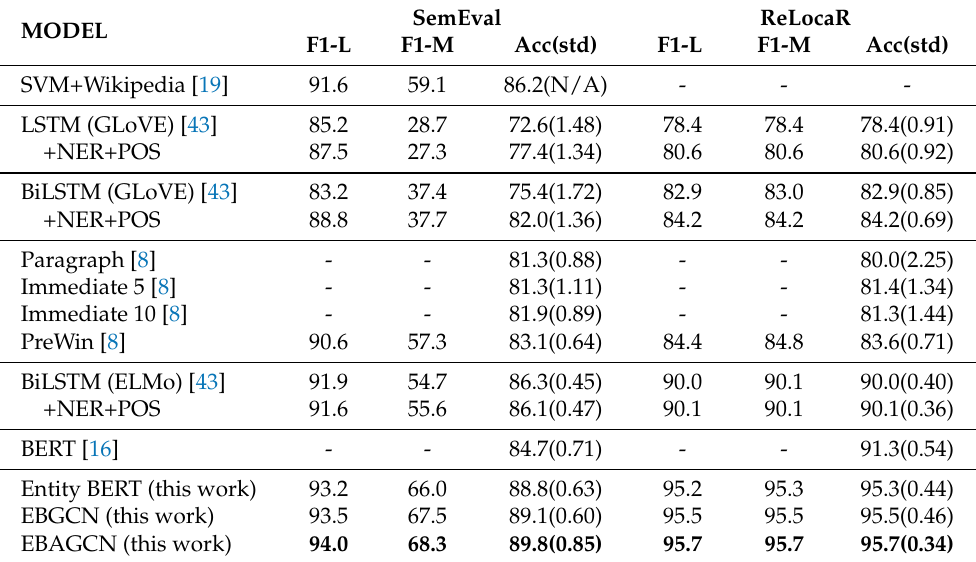
Table 1. Result on English datasets. On both benchmarks, the F1-score for either class and the overall accuracy are given in this table. “L” and “M” denote literal and metonymic class, respectively. +NER+POS means integrating both NER and POS features with the baseline model. In general, due to the application of advanced pre-trained language representation along with soft dependency clues, EBAGCN obtains best